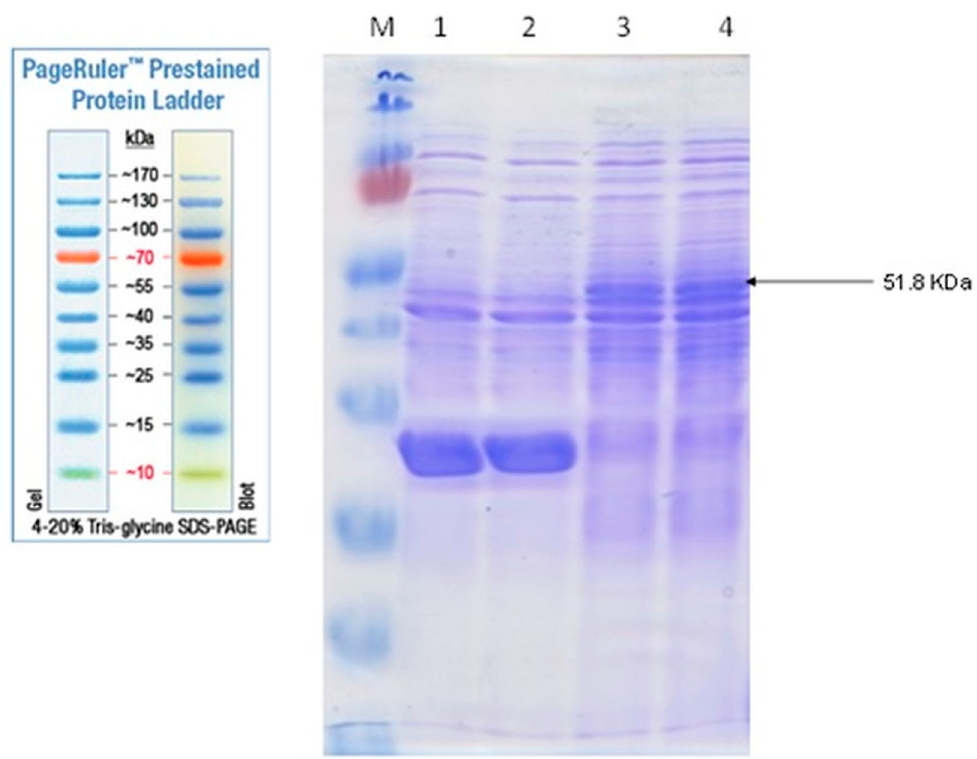
Figure 4. SDS-PAGE analysis of cell extracts of E. coli JM109 (lane 1), E. coli JM109 (pUC119) (lane 2), E. coli JM109 ( pCB ) pregrown in the presence of IPTG (lane 3) and E. coli JM109 ( pCB ) grown in the absence of IPTG (lane 4). In total, 10 µ L of extracts were subjected to SDS-PAGE., M PageRulerTM Prestained protein ladder (Thermo Scientific).